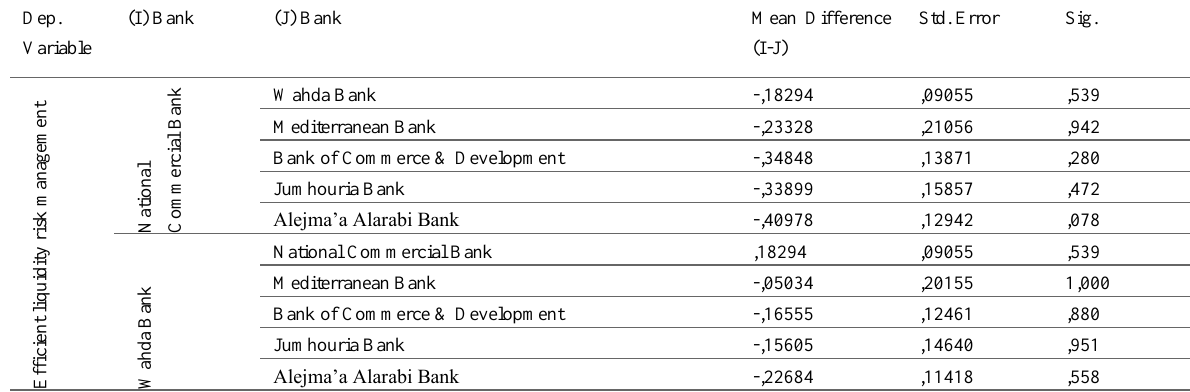
Table 11: Multiple Comparisons (Scheffe